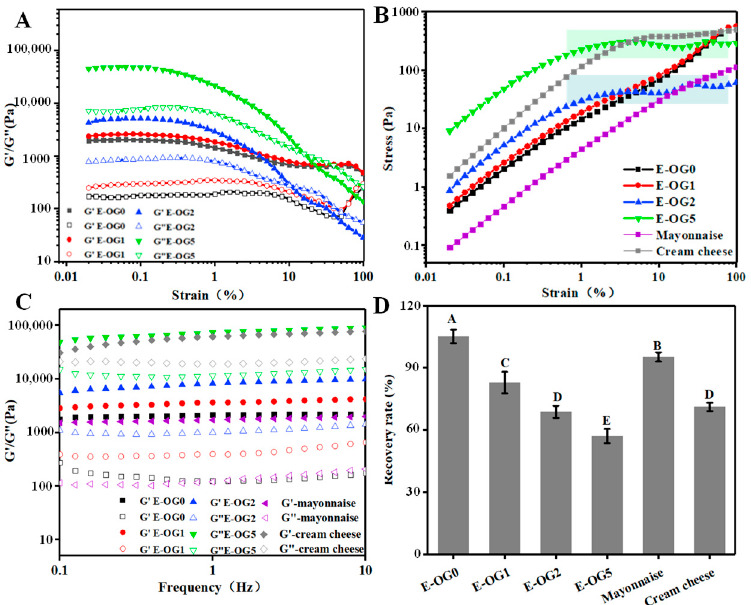
Figure 6. Rheological behavior of the emulsions. ( A ): Strain sweep. ( B ): Stress–strain curves obtained from strain sweeps. ( C ): Frequency sweep. ( D ): Thixotropy tests. Different uppercase letters represent significant differences. ( p < 0.05).